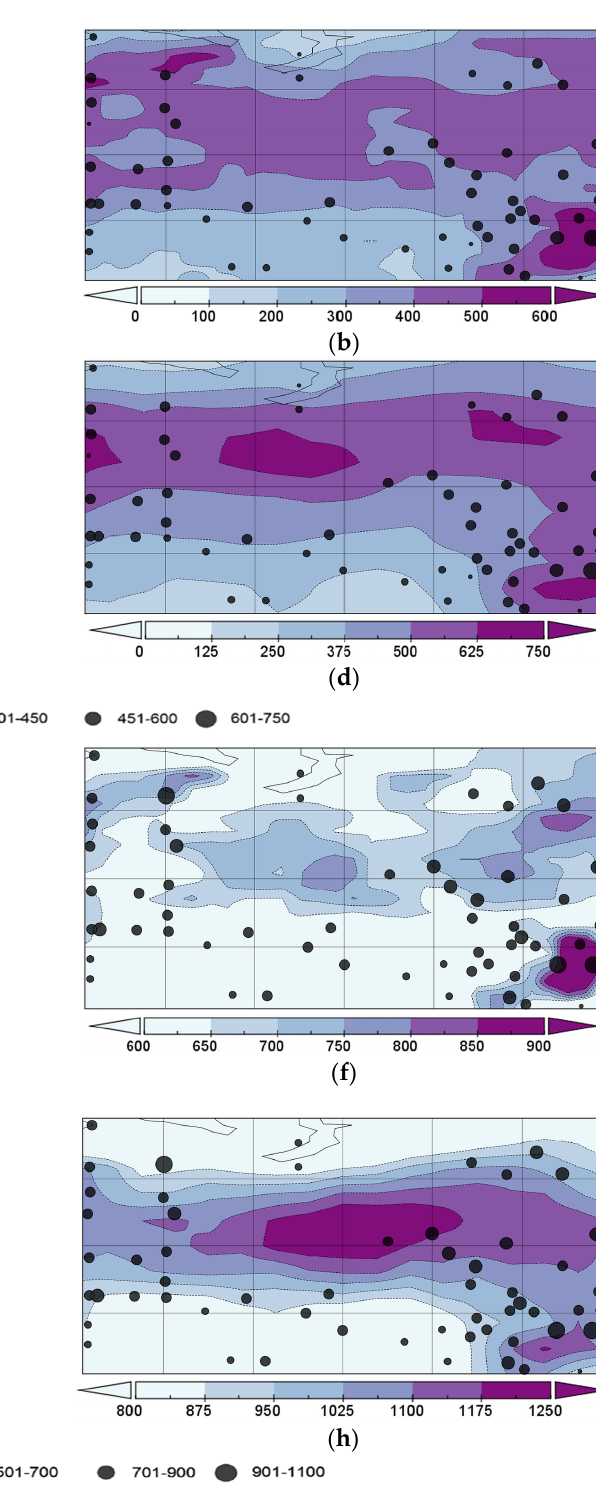
Figure 5. The spatial distribution of precipitation values (mm): ( a , e ) APHRO, ( b , f ) GPCC, ( c , g ) ERA5, and ( d , h ) NCEP. Upper panel: ( a – d ) extremely low (5%); lower panel: ( e – h ) extremely high (95%). Points correspond to the extreme values from the meteorological stations (mm).